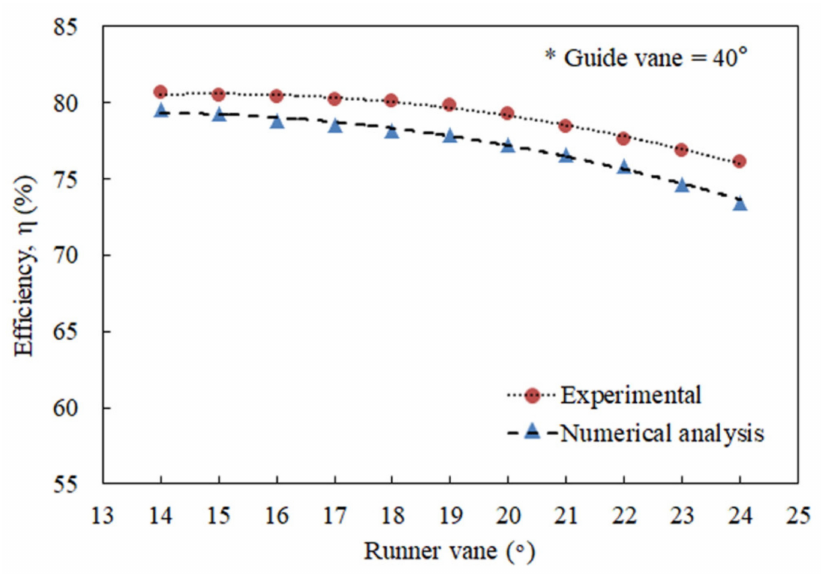
Figure 12. Comparison of turbine efficiency across various runner vane opening angles.